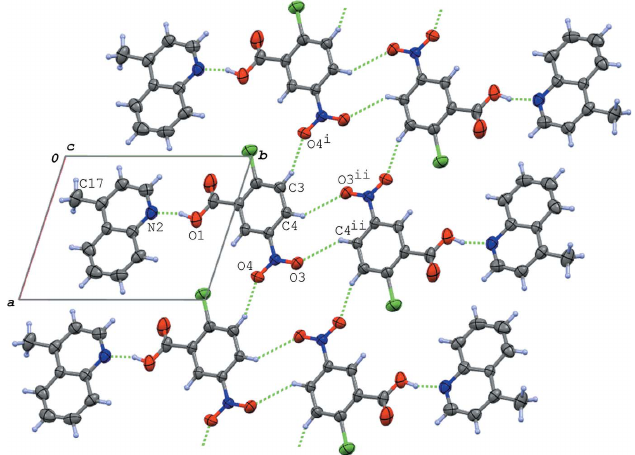
Figure 4 A packing diagram of (II) viewed along the c axis, showing the tape